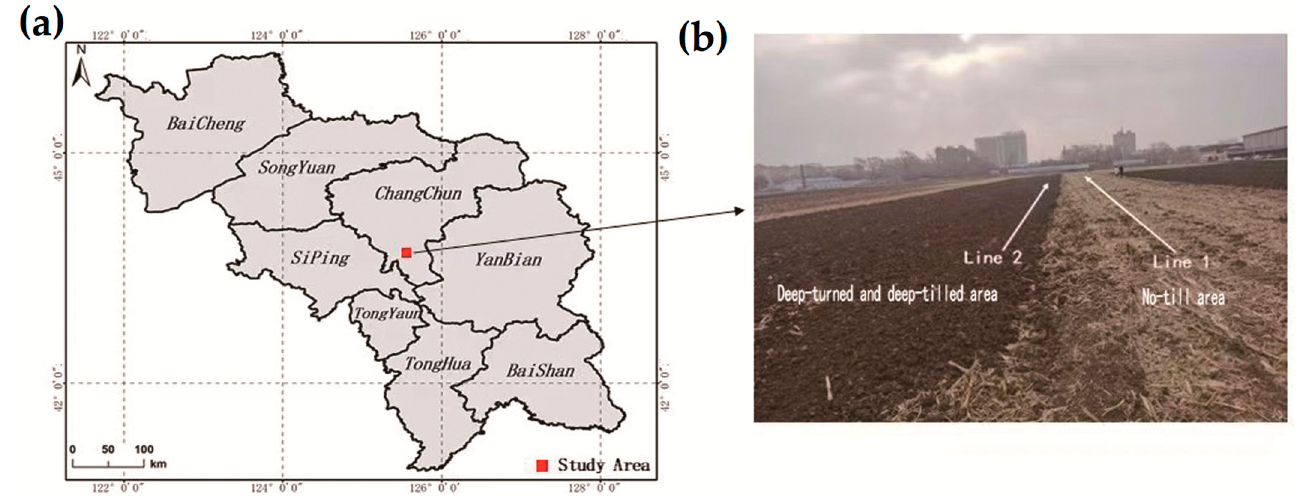
Figure 7. The location and situation of the experimental site. ( a ) Regional location map of the experimental site; ( b ) actual situation of the experimental site.